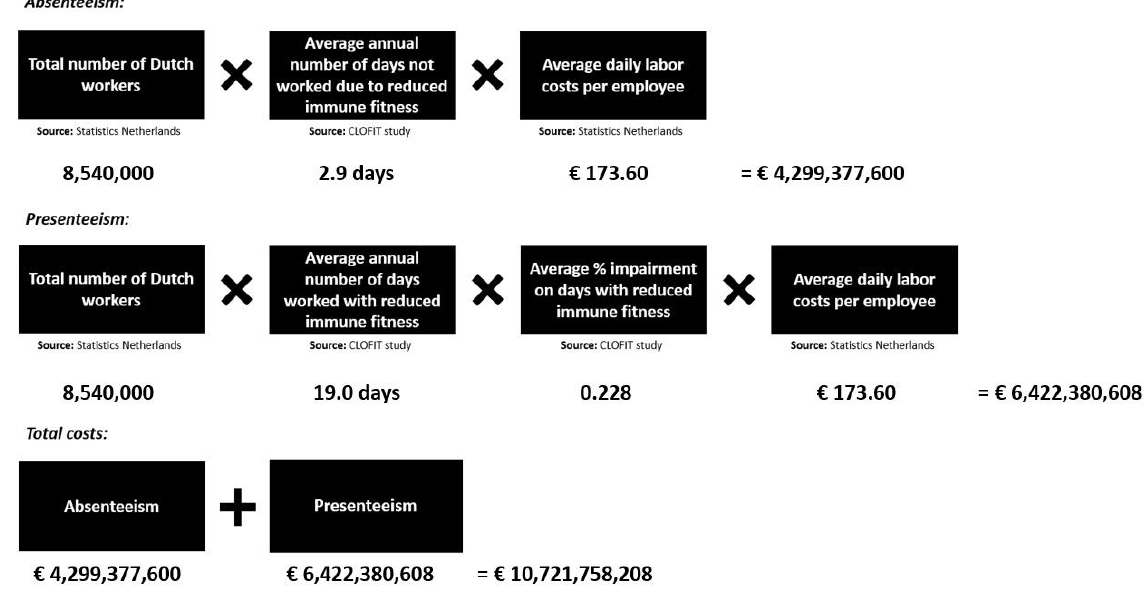
Figure 2. Estimated costs of reduced immune fitness for the Dutch economy in